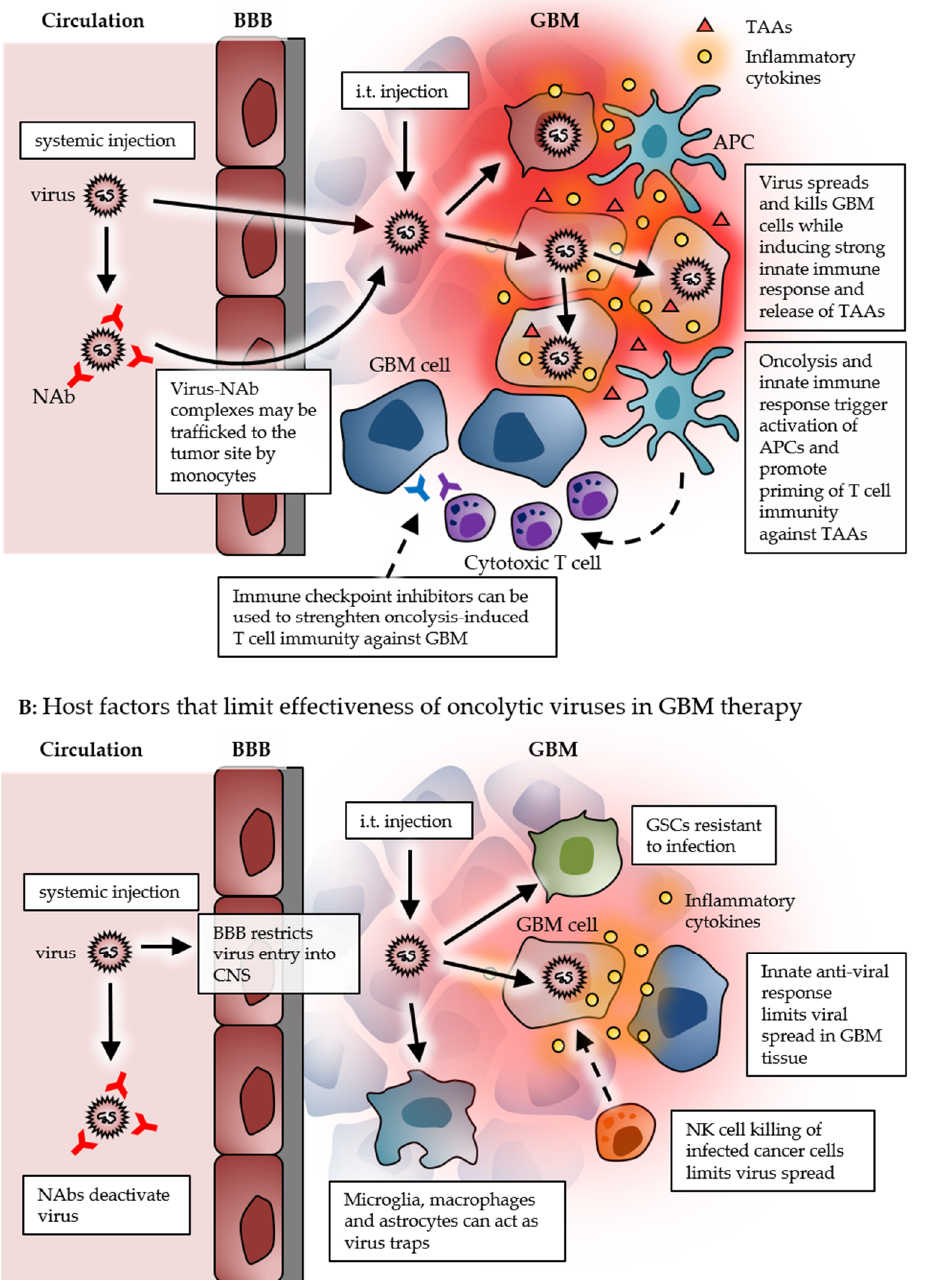
Figure 1. Schematic picture summarizing the events and factors related to successful oncolytic immunotherapy ( A ), and to limited effectiveness of oncolytic viruses ( B ) in GBM. Abbreviations: BBB: blood–brain barrier, GBM: glioblastoma, TAA: tumor-associated antigen, NAb: neutralizing antibody, APC: antigen-presenting cell, CNS: central nervous system, GSC: glioma stem cell, NK: natural killer cell.